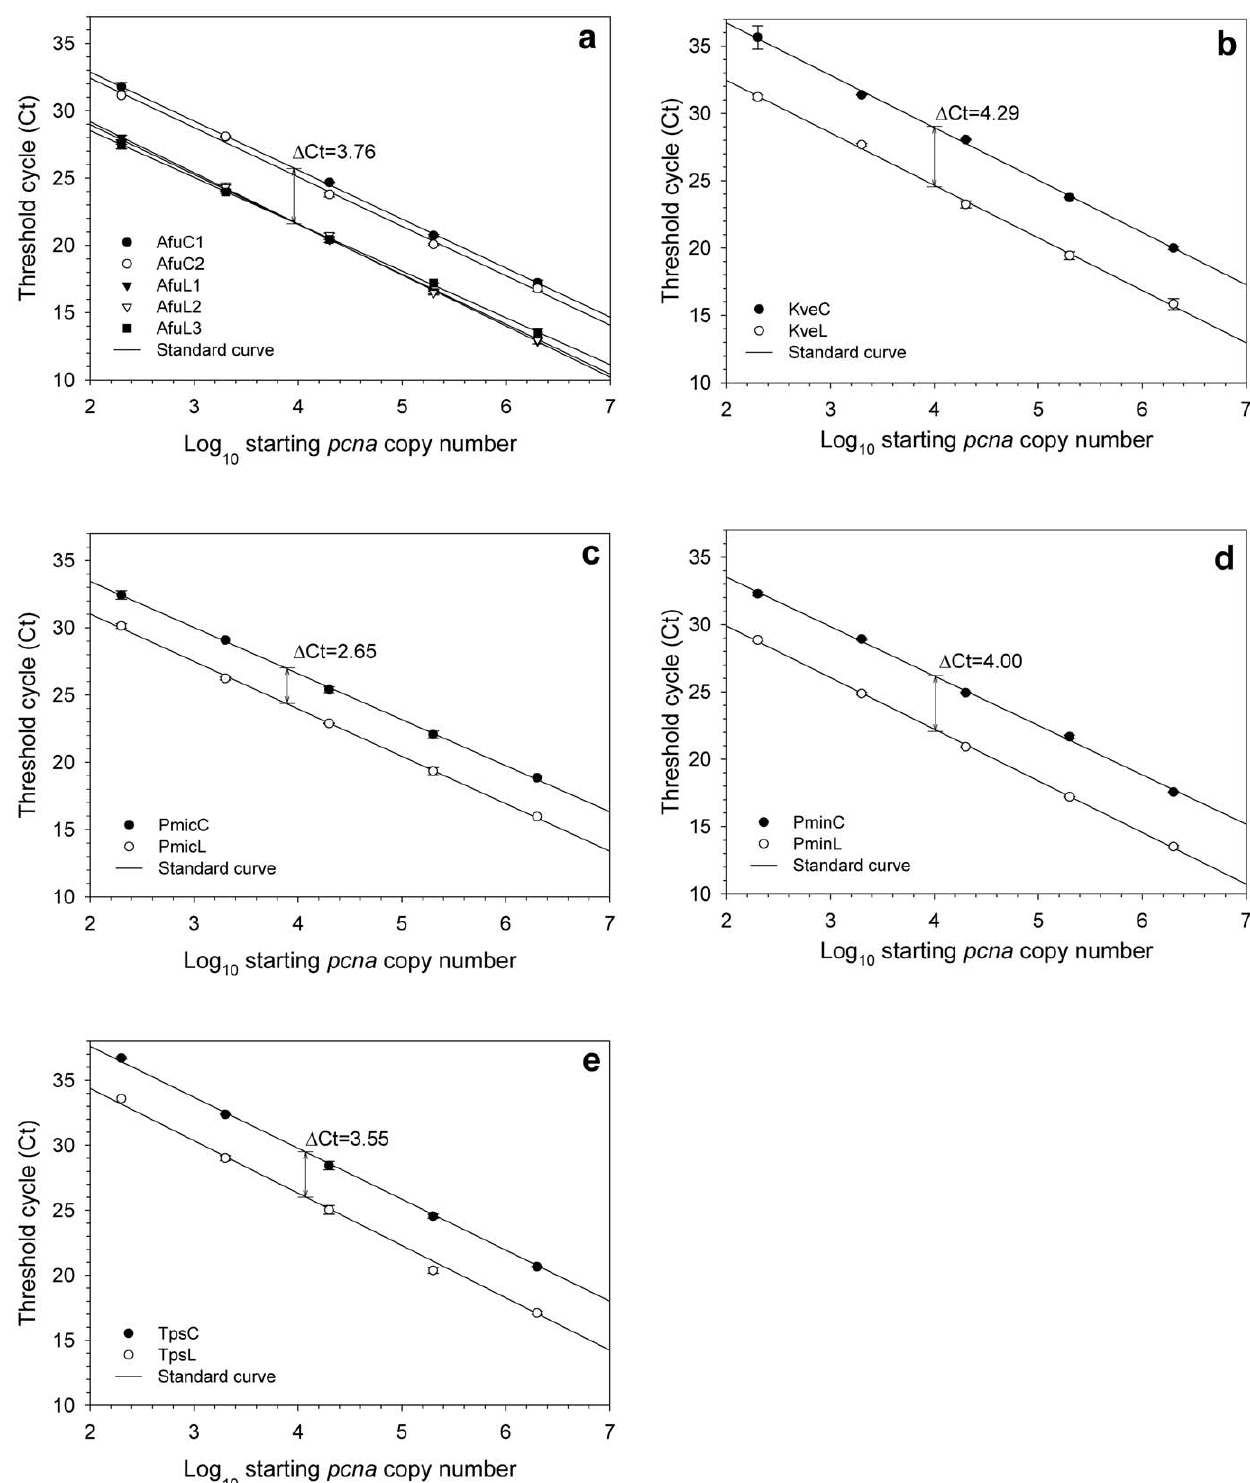
Figure 1. Standard curves with similar slopes and significant threshold cycle differences ( D Ct) between circular and linear standards in the pcna qPCR for (a) Alexandriumfundyense , (b) Karlodiniumveneficum , (c) Prorocentrummicans , (d) P.minimum , and (e) Thalassiosirapseudonana . Standard curves were linear regression lines between Ct and Log 10 starting pcna copy number (calculated from standard DNA concentration), each based on a type of standard DNA. Note that similar slopes of the standard curves indicate similar amplification efficiencies. All D Ct were calculated as the average Ct difference across serial dilutions and statistically significant ( p , 0.001). The error bars denote the standard deviations of Ct values among replicates.